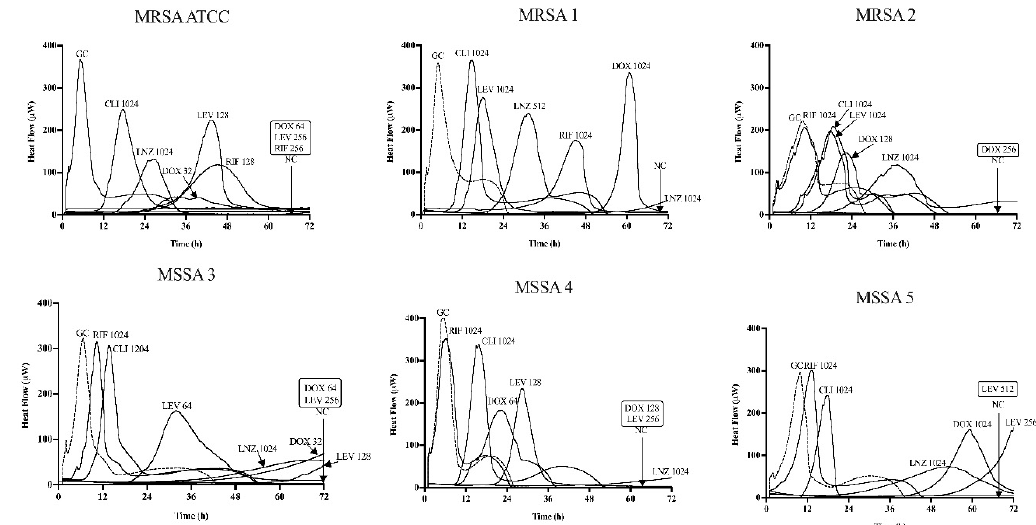
Figure 1. Microcalorimetry analysis of MRSA ATCC 43300 and five rifampin-resistance S. aureus biofilms inhibited by single antibiotics at different concentrations. Each curve shows the heat produced by viable bacteria presented in the biofilm after 24 h of antibiotic application. Numbers represent concentrations of the antibiotics (in μ g/mL) doxycycline (DOX), levofloxacin (LEV), linezolid (LNZ), clindamycin (CLI), and rifampin (RIF). Circled values represent the MBIC, defined as the lowest antimicrobial concentration leading to biofilm metabolism inhibition in the absence of antimicrobials for 72 h. GC, growth control; NC, negative control. Data of a representative experiment are reported.